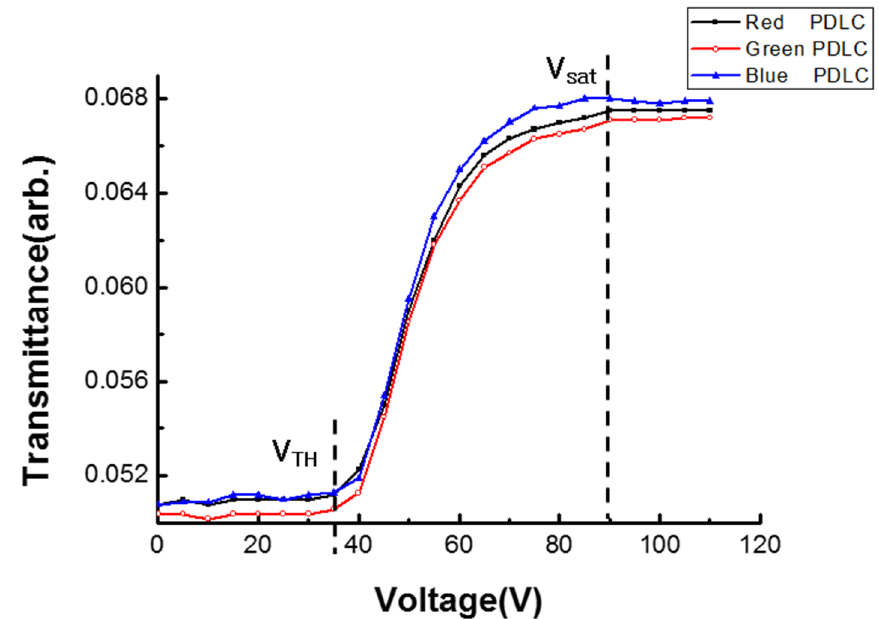
Figure 8. Measured V–T curves of the color PDLCs. The transmittance of all the color PDLCs begins to change around 40 V, and the transmittance is saturated around 90 V.